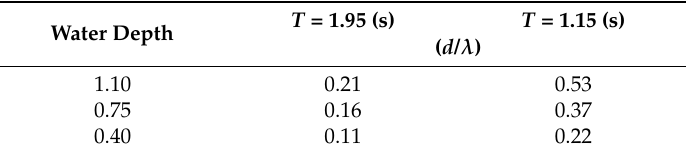
Table 1. Water depths, the ratio between depths and wavelength.